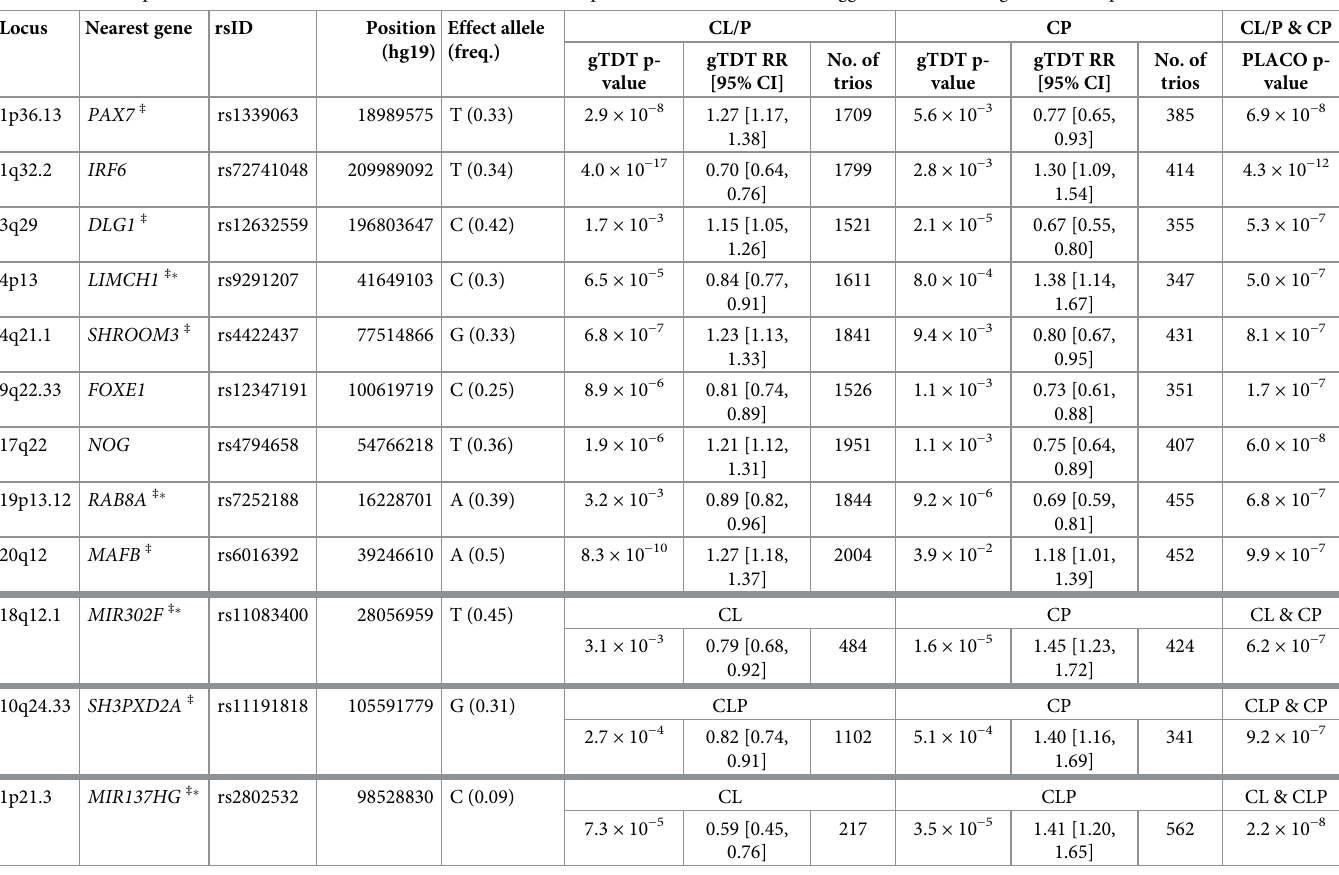
Table 1. Association results for the most significant markers from the 9 loci showing statistical evidence of genetic overlap between CL/P and CP, along with 3 addi- tional loci of genetic overlap between pairwise OFC subtypes. These loci were identified by PLACO at a suggestive threshold of 10 − 6 . The genetic overlap analysis is based on all trios from both POFC and GENEVA for CL/P & CP, or CL & CP, or CLP & CP, or CL & CLP. The different types of novel genes are marked by � or ‡ . The “No. of trios” columns give the numbers of complete informative case-parent trios as used by the gTDT method in analyzing each OFC subgroup/subtype. CL/P & CP PLACO p-value < 5 × 10 − 8 for a SNP indicates statistically significant association of the SNP with both CL/P and CP at the genome-wide level. Similar interpretations for the other PLACO p-values: CL & CP, or CLP & CP, or CL & CLP. PLACO p-value < 10 − 6 is considered suggestive evidence of genetic overlap. Locus Nearest gene rsID Position Effect allele (hg19)